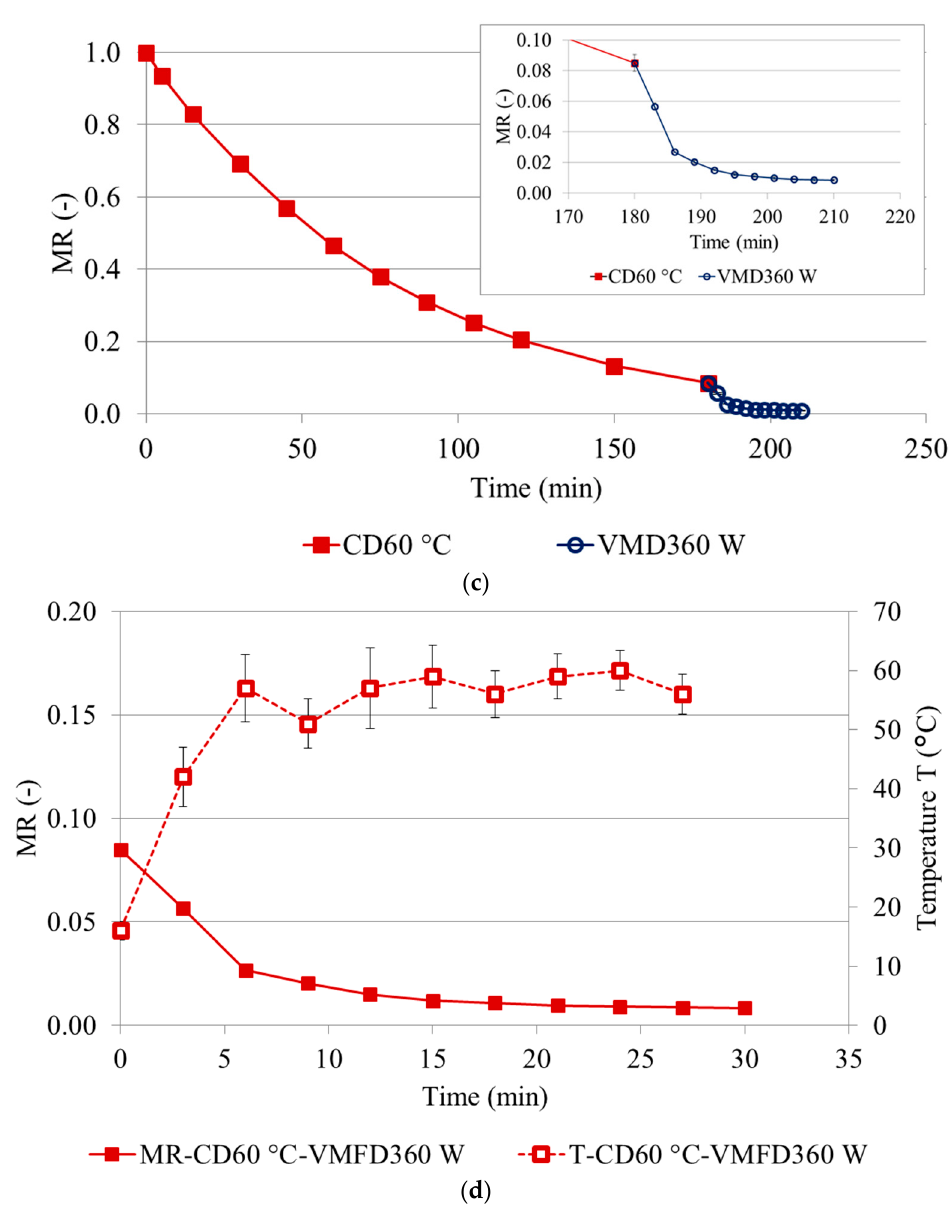
Figure 1. Drying kinetics of loquat fruit dehydrated by the studied drying conditions: ( a ) CD at 50, 60 and 70 °C, ( b ) VMD at 240, 360 and 480 W, ( c ) CPD at 60 °C followed by VMFD (360 W) with emphasis on VMFD ( d ). MR: moisture ratio. Convective drying (CD) at 50 °C (CD 50), 60 °C (CD 60) and 70 °C (CD 70), vacuum-microwave drying (VMD) at 240 W (VMD 240), 360 W (VMD 360) and 480 W (VMD 480) and combined drying (CPD-VMFD).